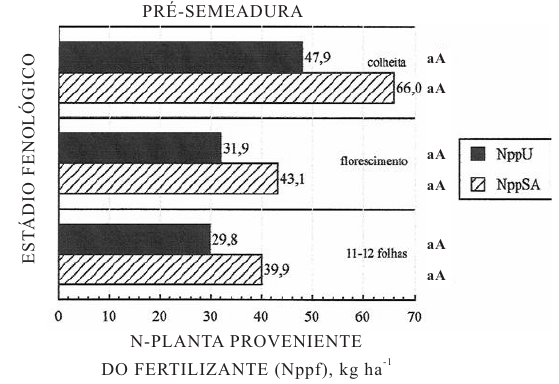
Figura 3. Nitrogênio na planta proveniente do sulfato de amônio ( NppSA ) e da uréia ( NppU ) aplicado em pré-semeadura, acumulado em três estádios da cultura de milho na safra 2000/2001, em sistema plantio direto. DMS (entre fontes – letras minúsculas) = 28,0ns. DMS (entre épocas – letras maiúsculas) = 20,7ns. CV (%) = 38,2.